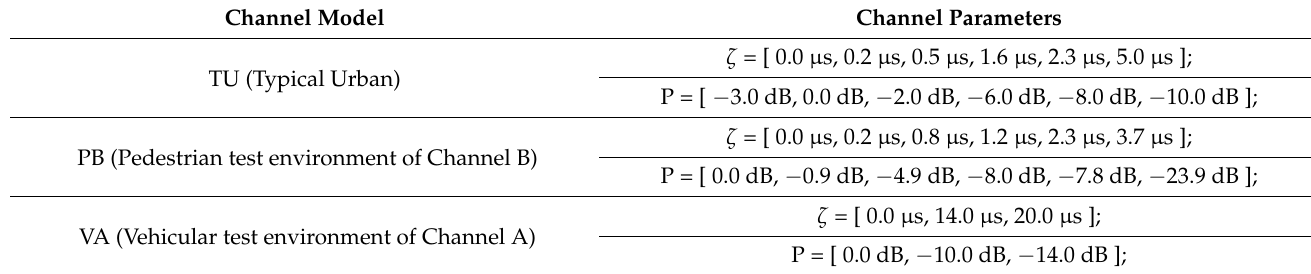
Table 3. The delay and power of different paths in the channel